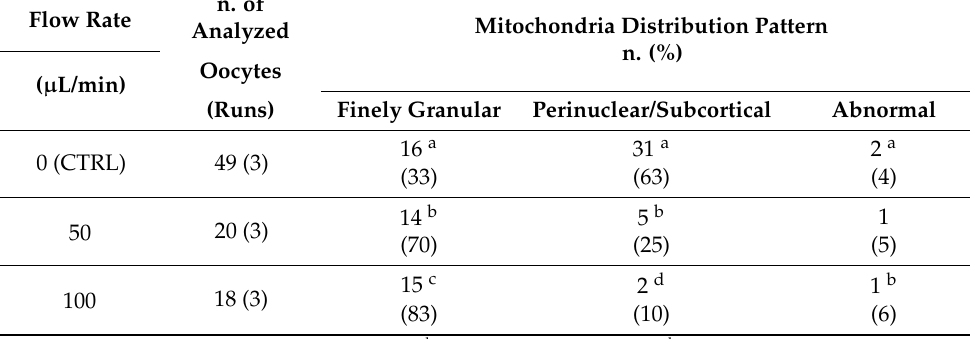
Table 3. Effects of native mIVM on mitochondria distribution pattern of sheep MII oocytes.